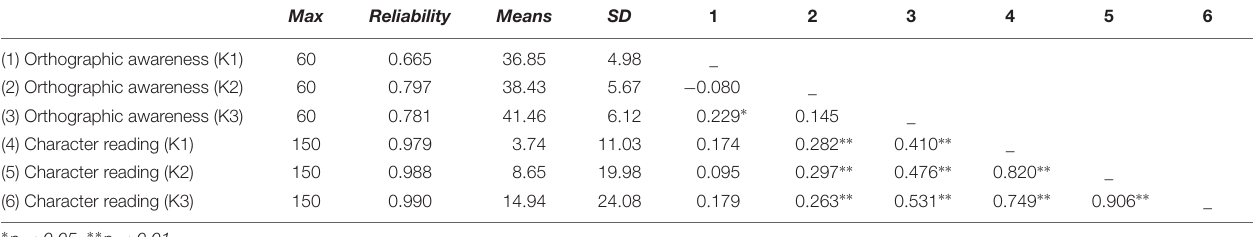
TABLE 1 | Reliabilities, means, SD and correlations of orthographic awareness and character reading in the kindergarten sample. Max Reliability Means SD